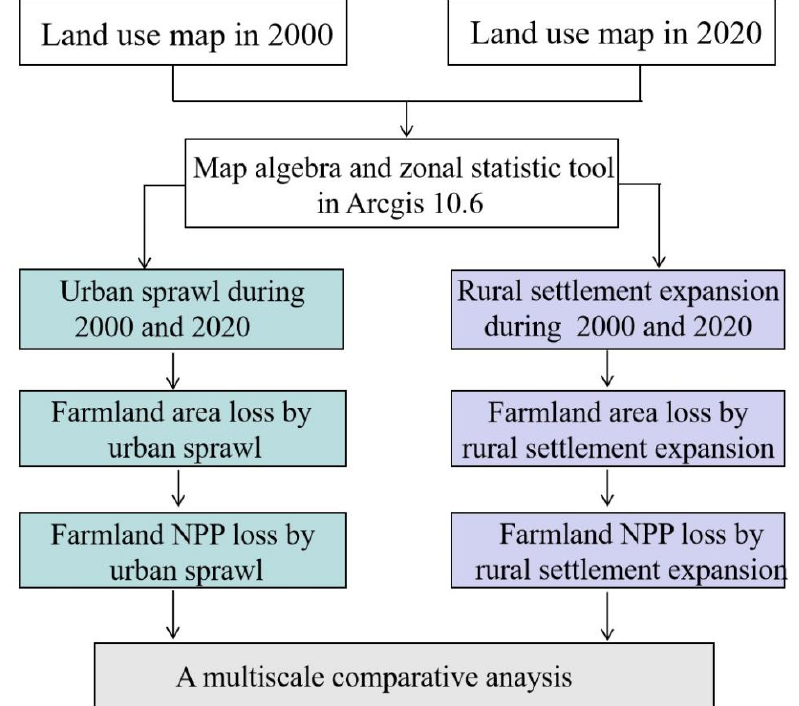
Figure 2. Research framework of the study.